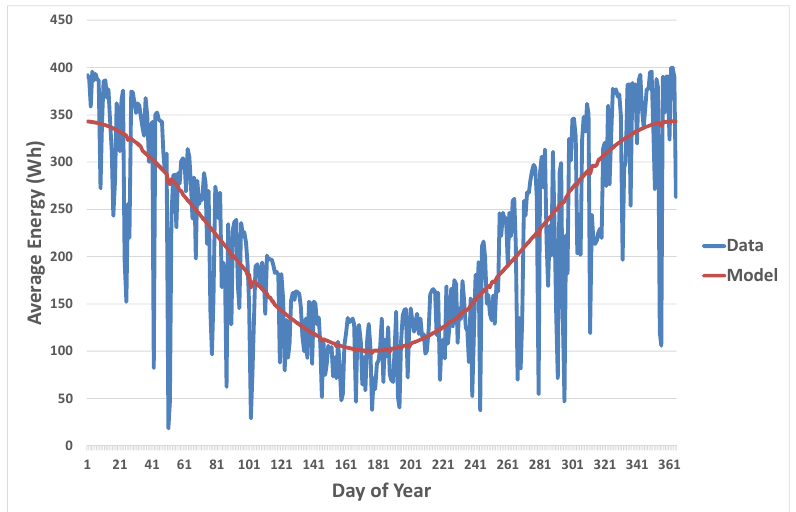
Figure 4. Daily Average Solar Radiation data plus model with no sidebands.